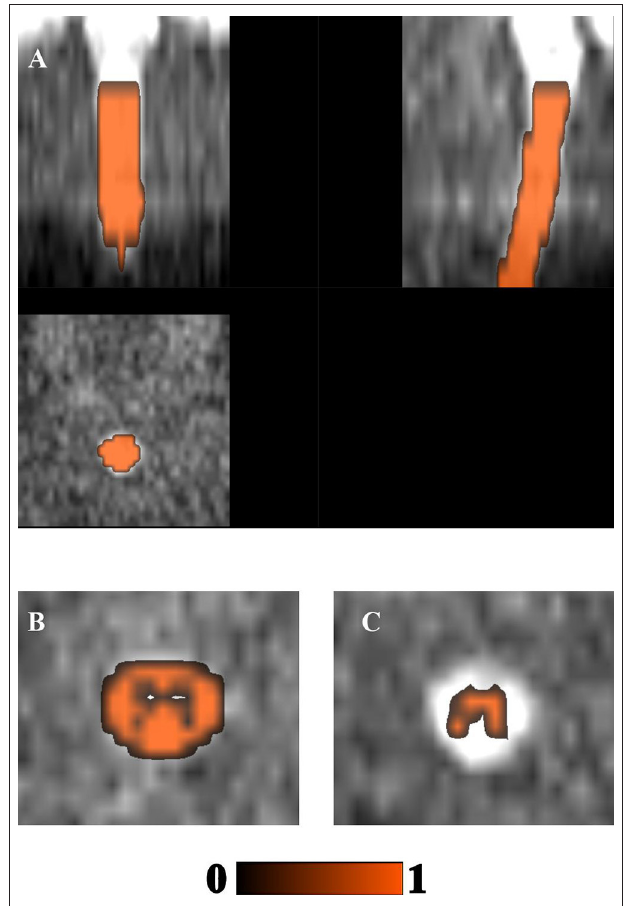
FIGURE 6 | Registration with PAM50 atlas and region-of-interest detection through atlas-based approach: (A) PAM50 atlas’ cord segmentation binary mask; (B) white matter; and (C) gray matter probabilistic masks warped to the subject’s diffusion kurtosis imaging motion-corrected mean image.